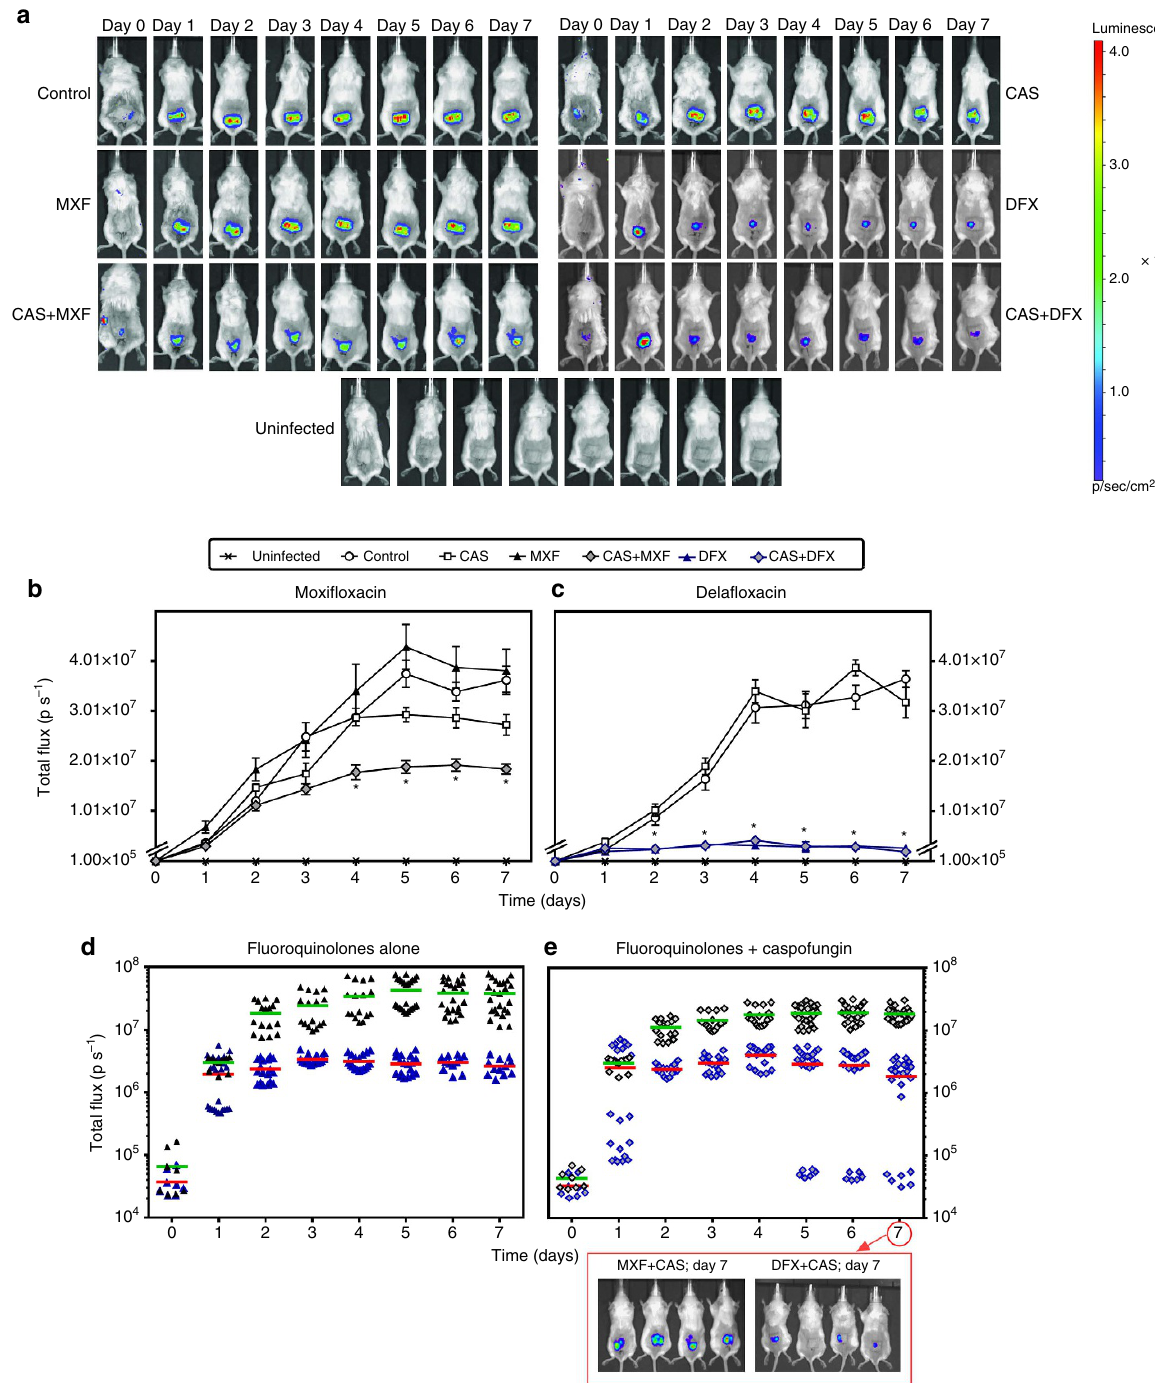
Figure 4 | Activity of fluoroquinolones alone or combined with caspofungin against the bioluminescent strain Xen36 in vivo . Bioluminescent signal emitted from catheters infected by Xen36, implanted at day 0 in the back of mice treated 24h after implantation and for the next 7 days with caspofungin (CAS) (4mgkg (cid:2) 1 of body weight once daily), moxifloxacin (MXF) or delafloxacin (DFX) (40mgkg (cid:2) 1 of body weight twice daily) or with a fluoroquinolone and caspofungin (each injected separately and according to its own schedule; (CAS þ MXF) or (CAS þ DFX)). All drugs were given by intraperitoneal injection. Control: animals implanted with infected catheters and treated by normal saline (0.9% NaCl) twice daily. Uninfected: animals implanted with non-infected catheters and left untreated (used for detection of background signal). ( a ) Representative bioluminescence images for one mouse per group: intensity of the transcutaneous photon emission represented as a pseudocolor image. ( b , c ) Quantitative analysis per fluoroquinolone (moxifloxacin and matching controls ( b ); delafloxacin and matching controls ( c )): in vivo bioluminescence signals expressed in photons per second (ps (cid:2) 1 ), with data expressed as means ± s.e.m. Statistical analysis: two-way ANOVA, Tukey post-hoc test. * P o 0.001 when comparing combinations versus fluoroquinolones alone. ( d , e ) Quantitative analysis comparing both fluoroquinolones when given alone ( d ) or in combination with caspofungin ( e ). The data are shown as individual values with the corresponding means represented by a horizontal coloured line. Images are those of four mice treated during 7 days by the